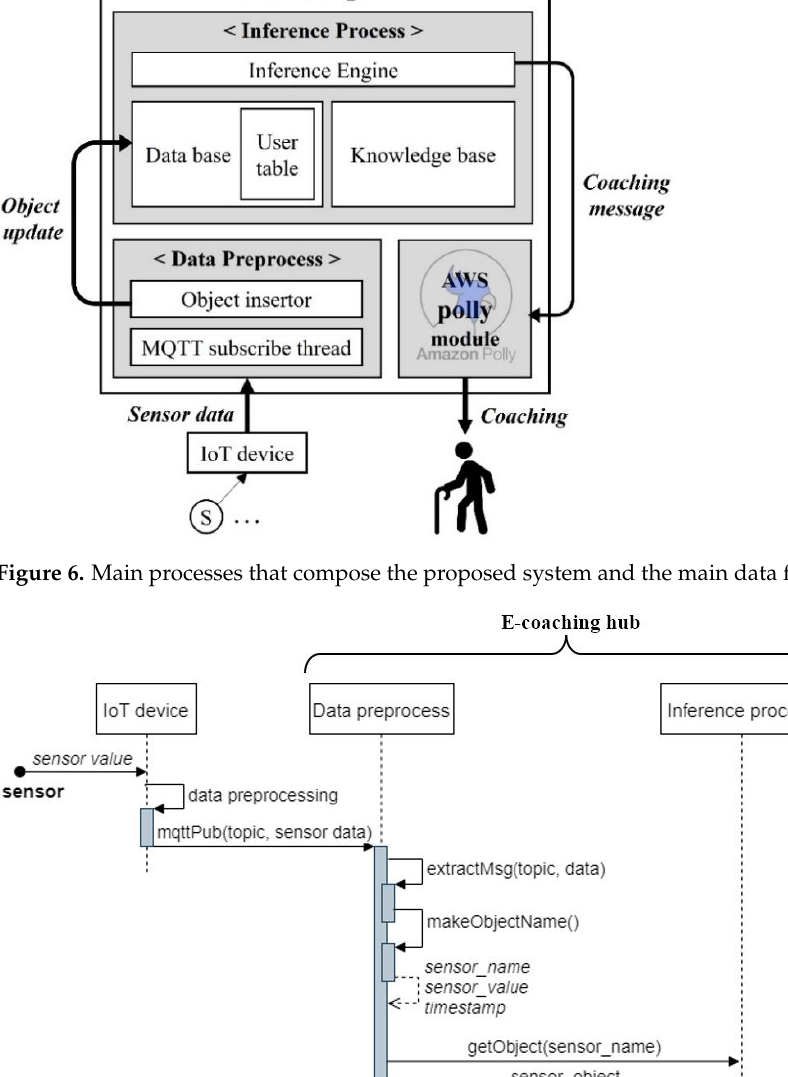
Figure 6. Main processes that compose the proposed system and the main data flows.